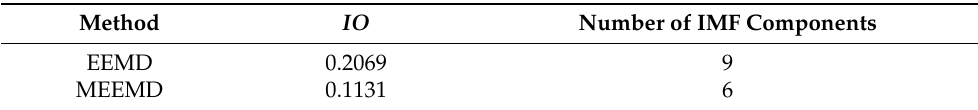
Table 3. Comparison of Ensemble empirical mode decomposition (EEMD) and Modified ensemble empirical mode decomposition (MEEMD) indicators.